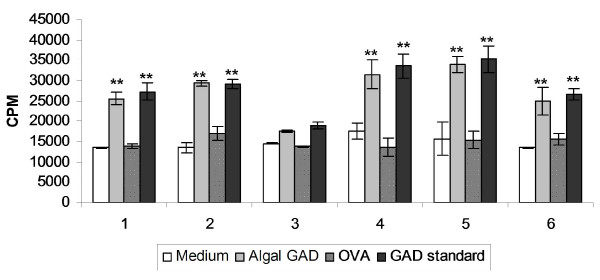
Spleen cell proliferation responses to algal-derived hGAD65. Individual 8-week-old NOD mice were tested for spontaneous proliferation of splenocytes to insect cell-derived hGAD65 standard, algal-derived hGAD65 or to the unrelated protein antigen ovalbumin (OVA). Error bars represent the standard deviation. ** above bars indicates a significant difference from OVA and medium alone (p < 0.05).